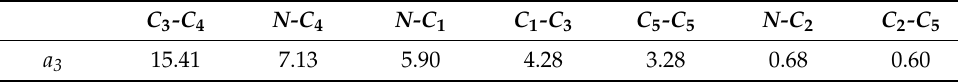
Table 2. Fitted anharmonic parameters ( a 3 ) of the bond energy curves for ID-GY.